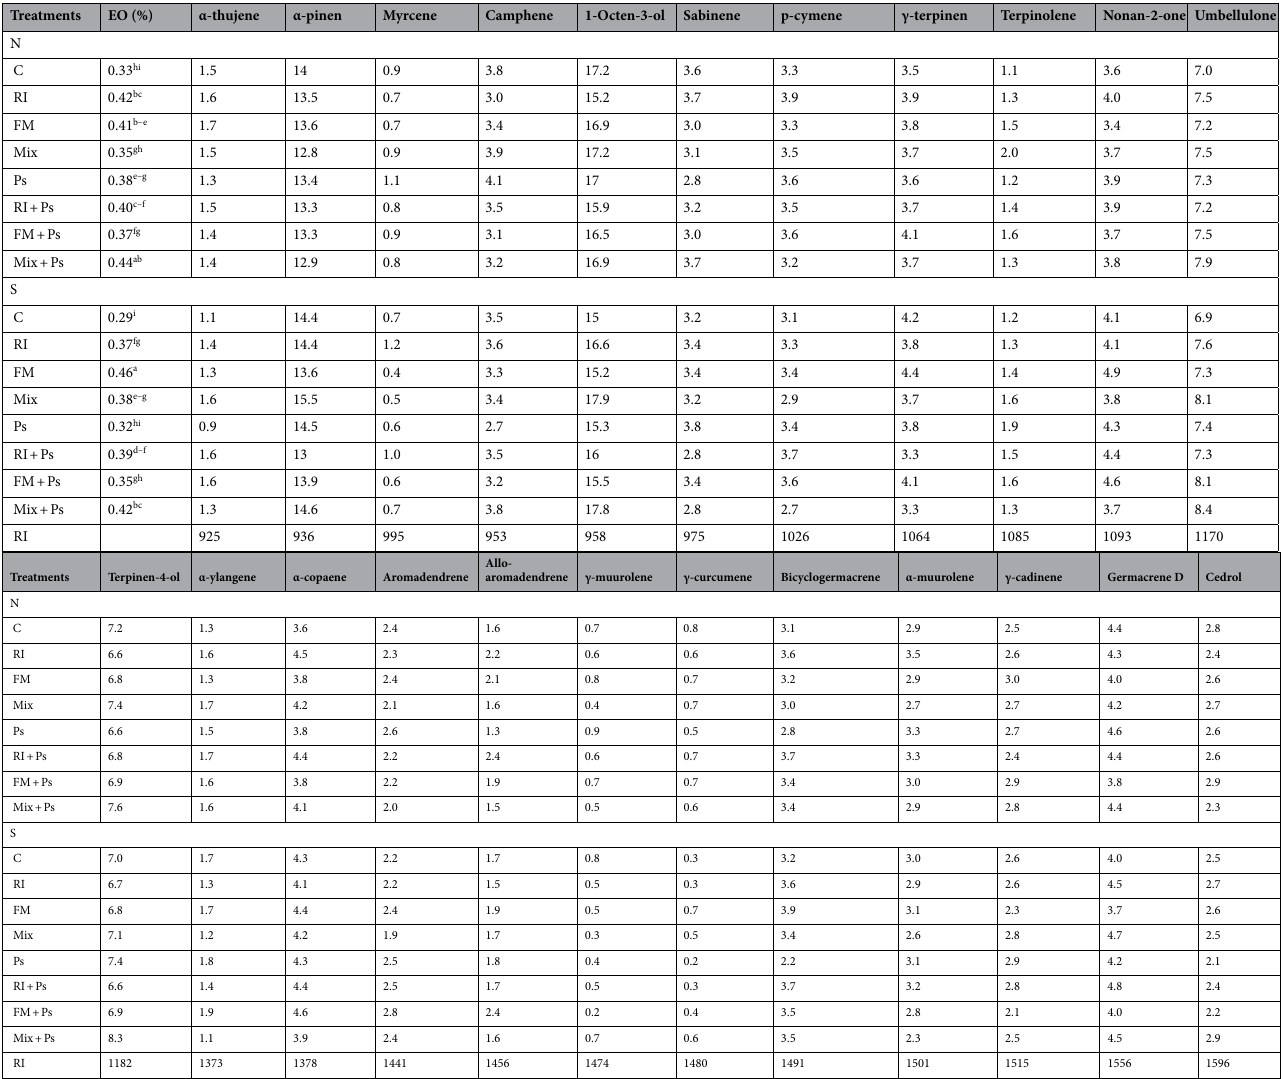
Table 4. Essential oil composition of Arizona cypress seedlings inoculated with two arbuscular mycorrhizae ( Rhizophagus irregularis and/or Funneliformis mosseae ) and one rhizobacterium ( Pseudomonas fluorescens alone or in combination with AMF) grown under two irrigation regimes. Within each column means followed by the same letters do not express significant differences according to LSD at P < 0.05. N well watered